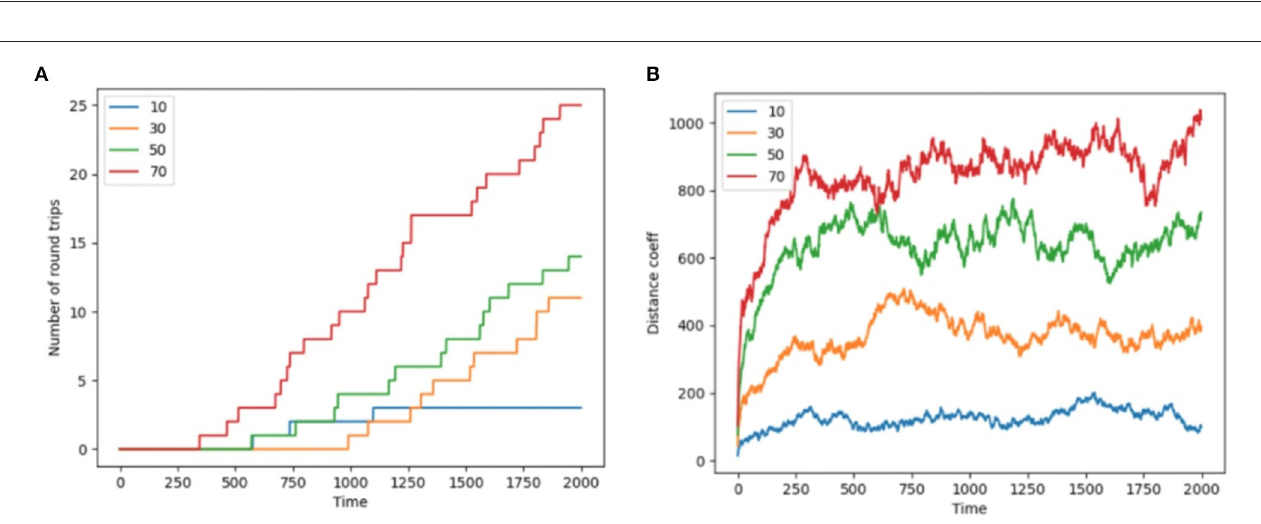
FIGURE 3 | Round trips and distance coefficient. (A) The number of completed round trips (Y axis) through time (X axis) for different numbers of nestmates in the simulation (traces of different color as per legend) for a representative trace run of each colony size. (B) Swarm distance coefficient (Y axis, see section The Foraging Task for equation) plotted through time (X axis) for different numbers of nestmates in the simulation (traces of different color as per legend) for the same representative runs.